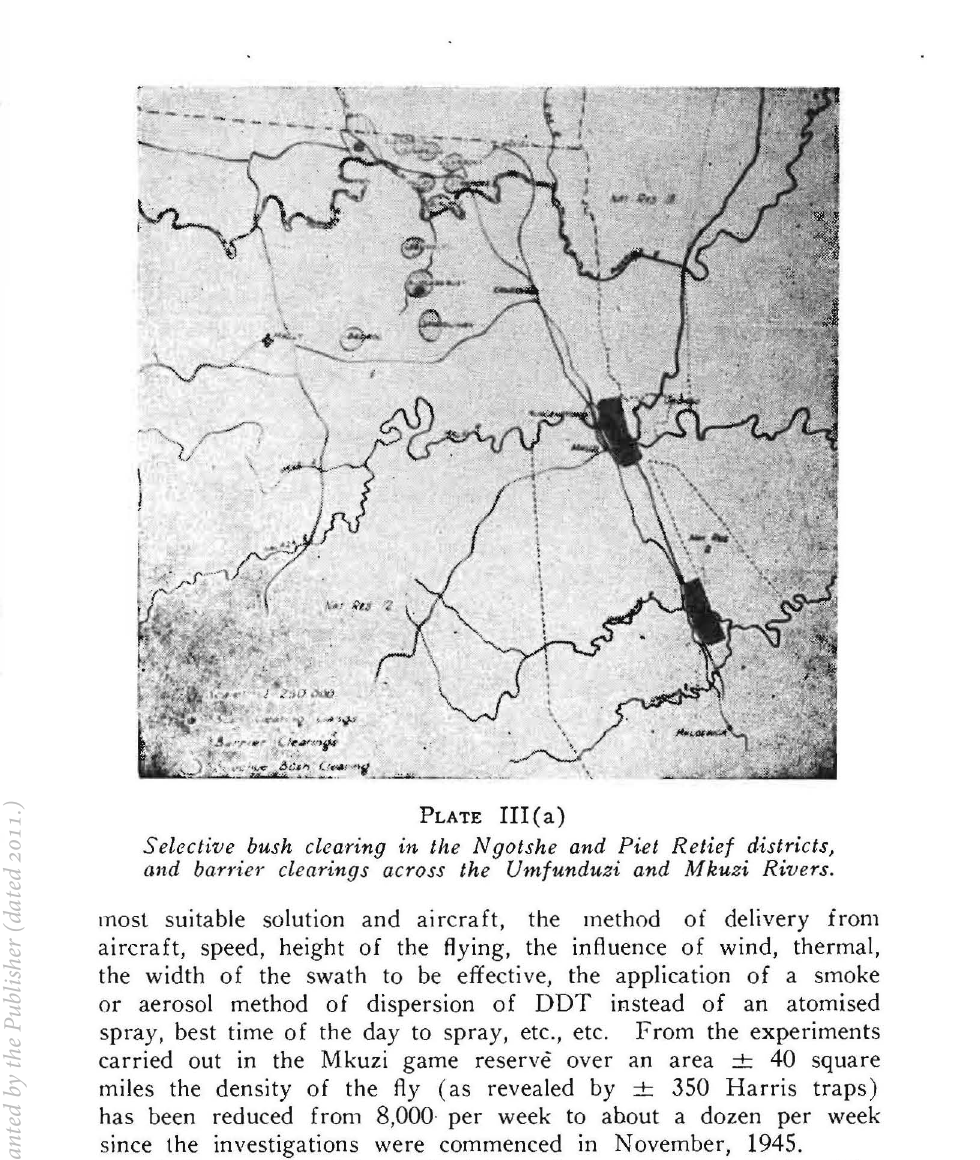
the method oi delivery